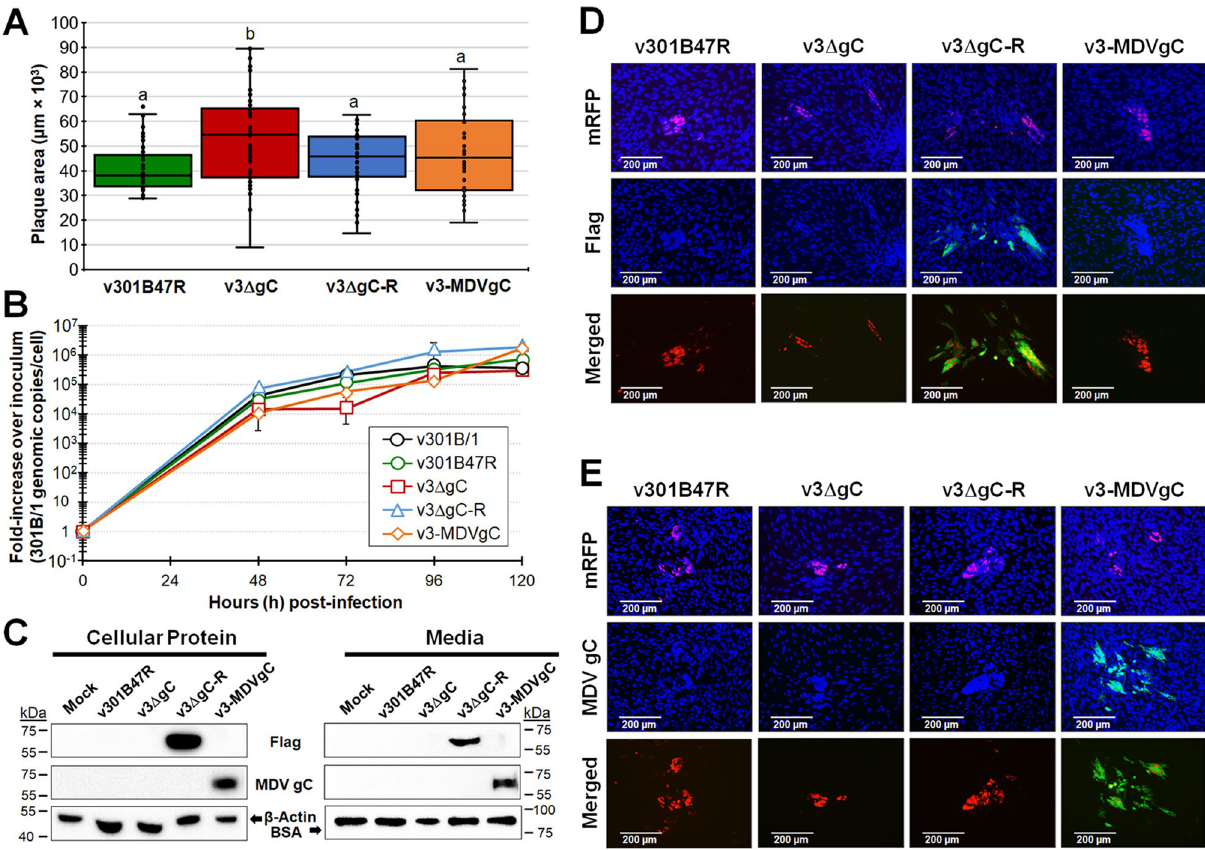
Figure 3. Replication and expression of proteins in cell culture. ( A ) Mean plaque areas for viruses reconstituted from r301B47R, r3ΔgC, r3ΔgC-R, and r3-MDVgC were measured and shown as box & whisker plots. Significant differences were determined using one-way ANOVA ( p < 0.05, n = 200). Mean plaque areas with different letters are significantly different using LSD and Tukey’s post hoc tests ( p ≤ 0.05). ( B ) Multi-step growth kinetics was used to measure virus replication in CEC cultures. The mean fold-change in viral DNA copies over the inoculum is shown for each virus and time point. There were no differences in virus growth ( p > 0.05, two-way ANOVA, LSD, n = 3) ( C ) Western blotting to confirm 301B/1 gC and MDV gC expression. Both total cellular protein and infected cell culture media were used to detect 3 × Flag tagged 301B/1 gC and MDV gC. Anti-Flag M2 was used to detect 301B/1 gC, while anti-MDV gC A6 antibody was used to confirm MDV gC expression. For protein loading control, mouse anti-β-actin was used for total protein, while anti-BSA was used for infected cell media. ( D and E ) Expression of 301B/1 gC in v3ΔgC-R and MDV gC in v3-MDVgC. Representative plaques for all four viruses were stained with anti-Flag ( D ) or -MDV gC A6 ( E ) antibodies with goat anti-mouse-Alexa488 (green) as secondary antibody. Fluorescent expression of mRFP (red) was directly visualized and cells were counterstained with Hoechst 33342 to visualize nuclei. Only anti-Flag ( D ) or -MDV gC ( E ) and pUL47mRFP are shown in the merged